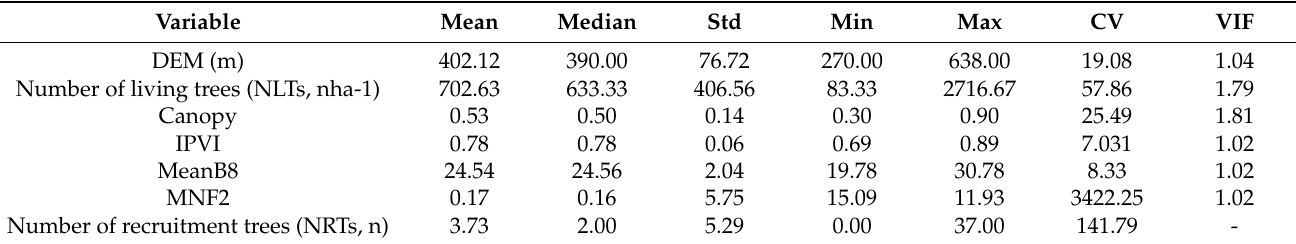
Table 2. Basic statistical indicators of the model